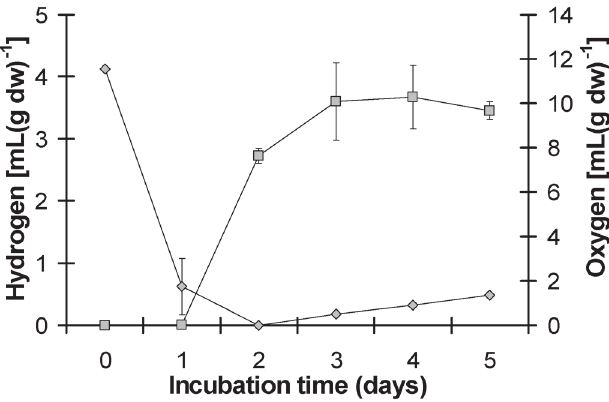
Fig 1. Kinetic of hydrogen production and oxygen consumption of the lichen Pleurosticta acetabulum .